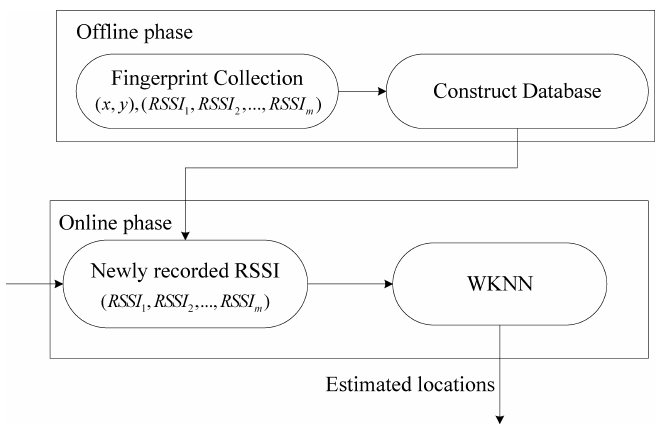
Figure 2. WiFi fingerprinting-based